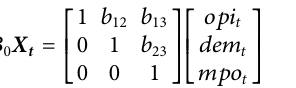
Frontiers in Energy Research |